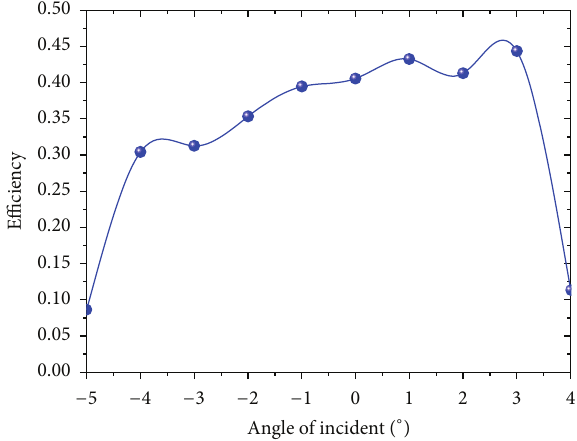
Figure 6: Schematic of the proposed binary blazed grating coupler: (a) top view and (b) side view.